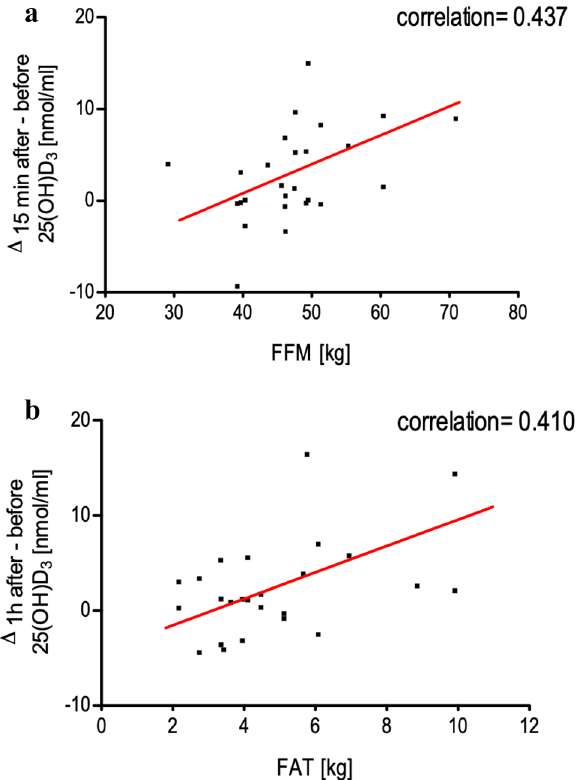
Figure 3. ( a ) The correlation between the delta change in 25(OH)D 3 before and 15 min after the exercise and free fatty mass (FFM) in all boys. ( b ) The correlation between the delta change in 25(OH)D 3 before and 1 h after a single bout of exercise and fat [kg] in all boys. For ( a ) and ( b ) n = 26 (10–14 years), Pearson’s linear